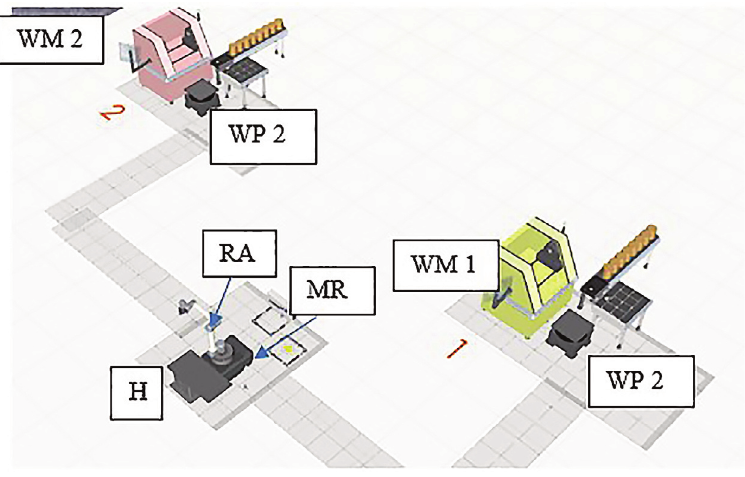
Fig. 2. Robot arm (RA) moved by mobile robot (MR) between working positions (WP 1, WP 2). WM 1 and WM 2 are working machines, H is the home position for mobile robot.